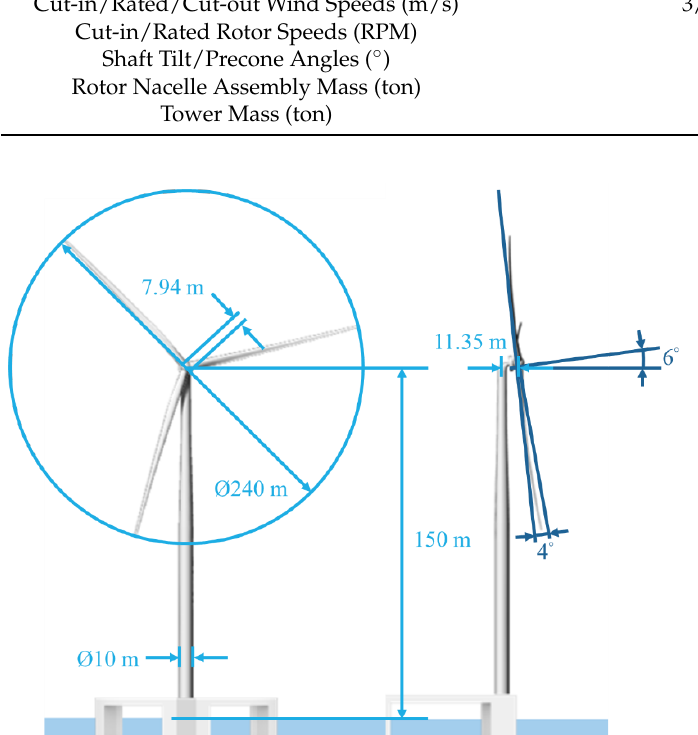
Table 3. Specifications of IEA 15 MW offshore wind turbine.